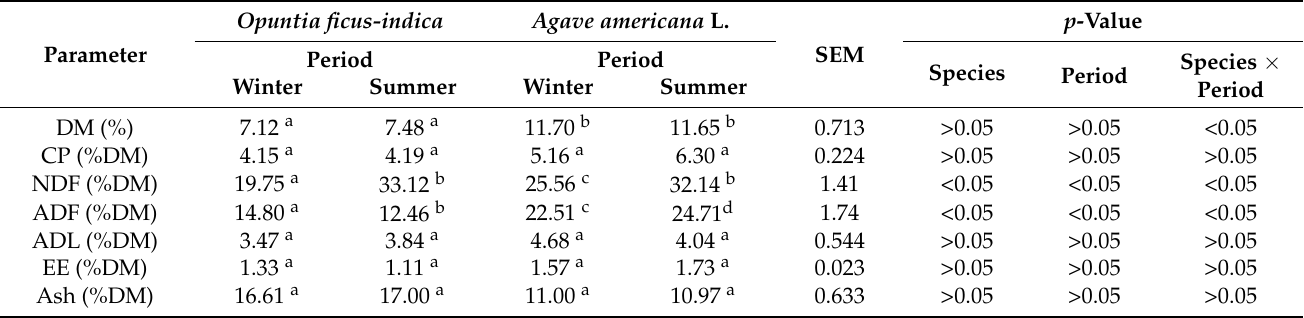
Table 1. Chemical Composition of the different plants to the different periods.